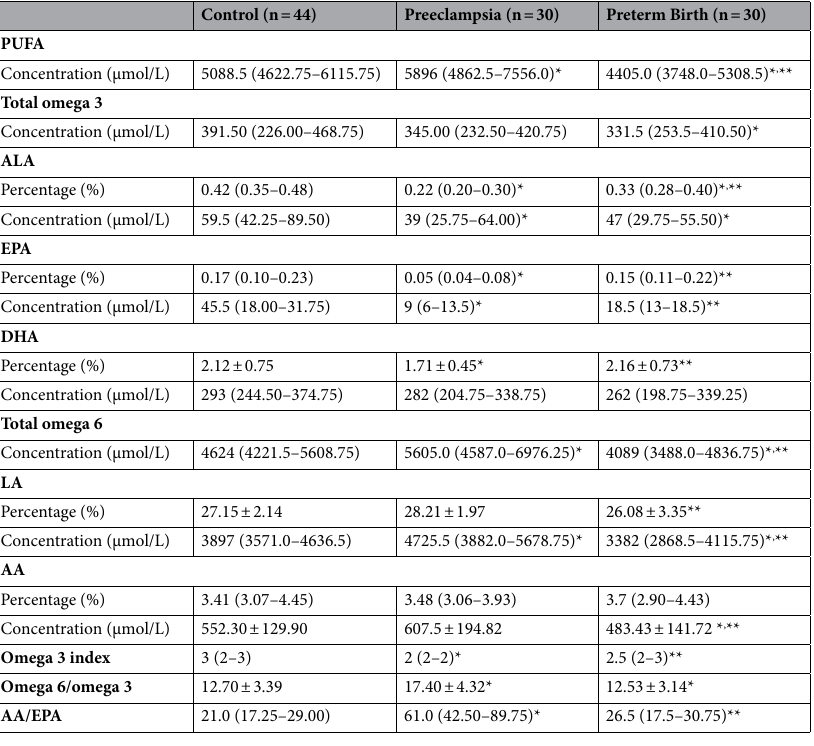
Table 2. Serum percentage and concentrations of LCPUFA (n = 104). Data presented in Mean ± SD or Median (IQR). *Significances to control ( p < 0.05). **Significances to preeclampsia ( p <